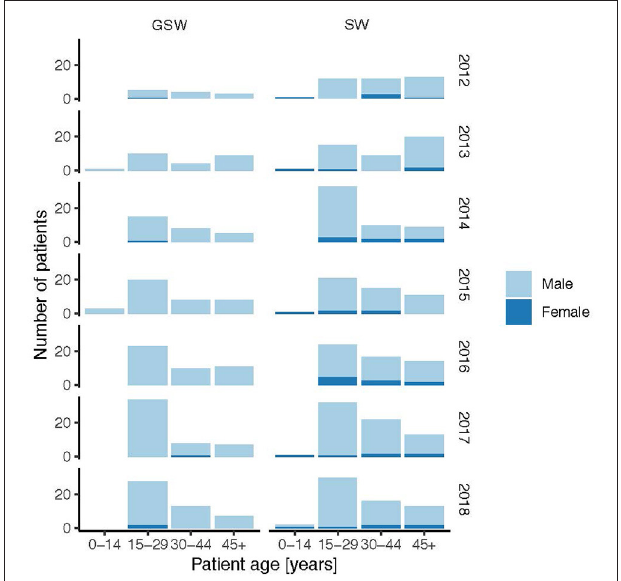
FIGURE 4 | Age and sex distributions of the GSW and stab wound subgroups per year. GSW, gunshot wounds.